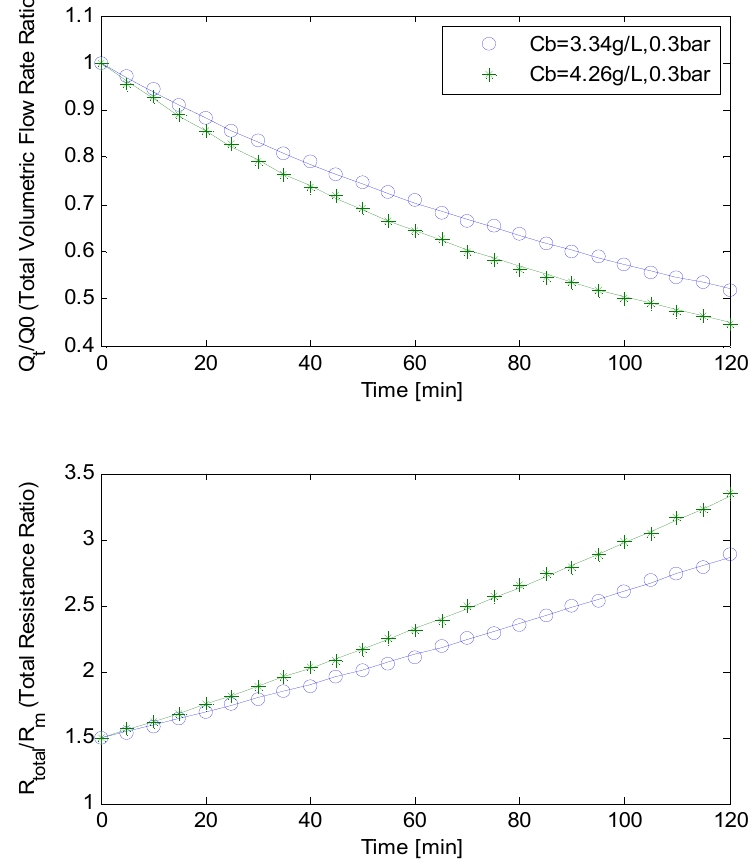
Figure 6. Flux decline and total resistance for flux step at TMP 30 kPa for FUV-185-A15R. At a constant TMP of 45 kPa and MLSS concentration of 3.34 and 4.26 g/L, the initial flow